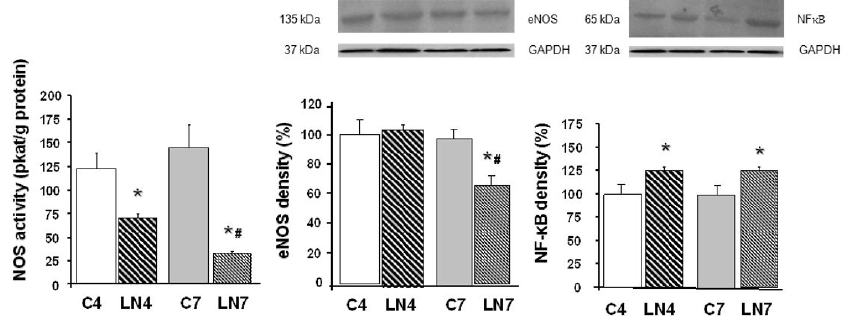
Figure 7. E ff ect of 4- and 7-week N G -nitro-L-arginine methyl ester (L-NAME) treatment on NO synthase (NOS) activity, endothelial NOS (eNOS) protein expression, and nuclear factor-kappaB (NF- κ B, p65) protein expression in the cerebellar cortex. Group treated with L-NAME for 4 weeks (LN4) and age-matched controls (C4), group treated with L-NAME for 7 weeks (LN7) and age-matched controls (C7). * p < 0.05 compared to age-matched controls, # p < 0.05 compared to